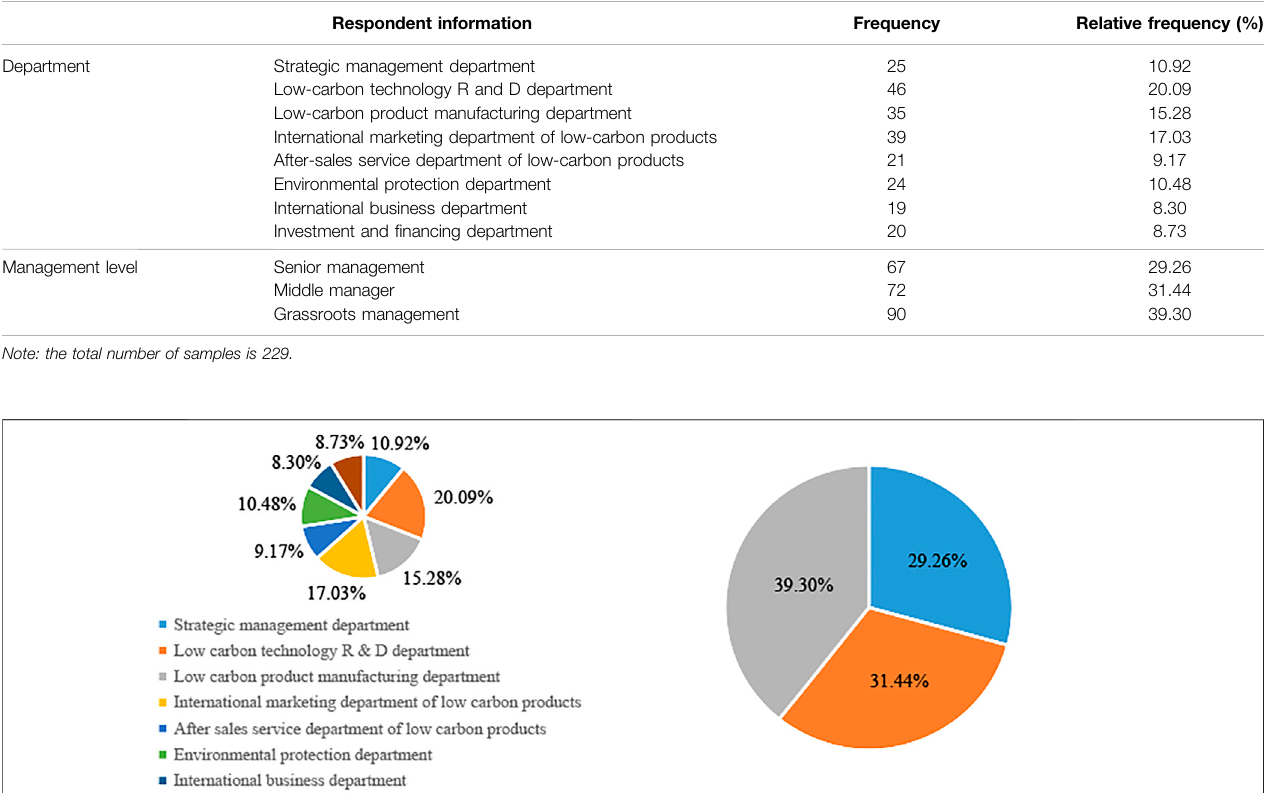
TABLE 2 | Information statistics of respondents.